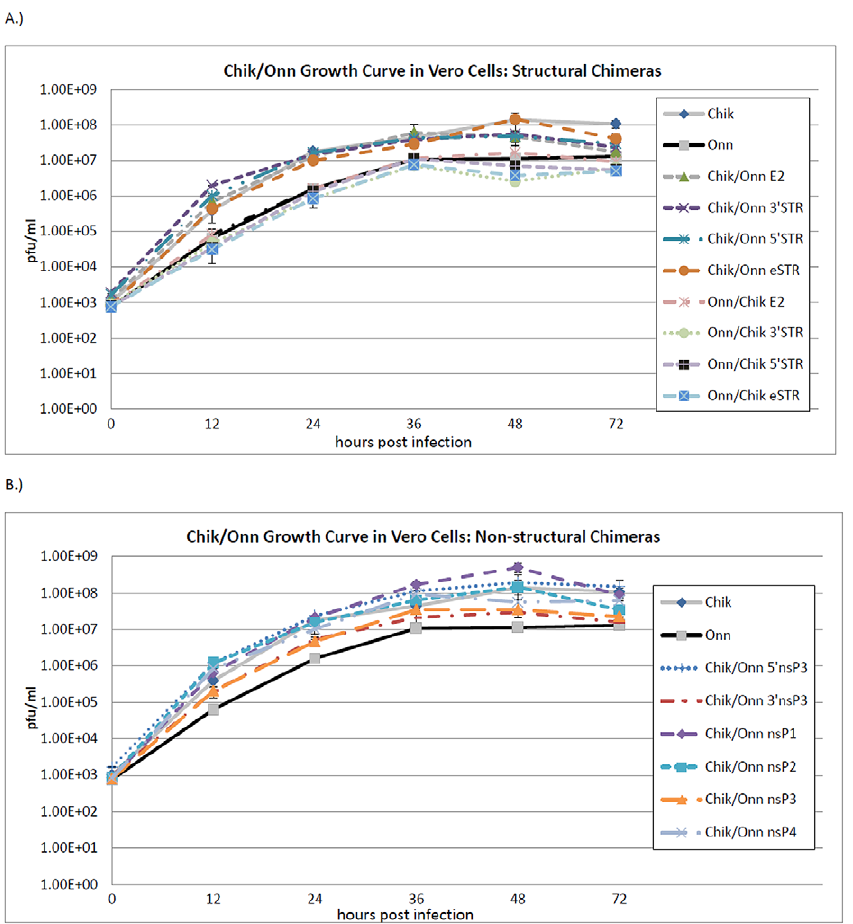
Figure 3. Growth curves for CHIKV and ONNV chimeras in Vero cells after infection at 0.1 MOI. (A) Structural region chimeric viruses, (B) Non-structural region chimeric viruses.